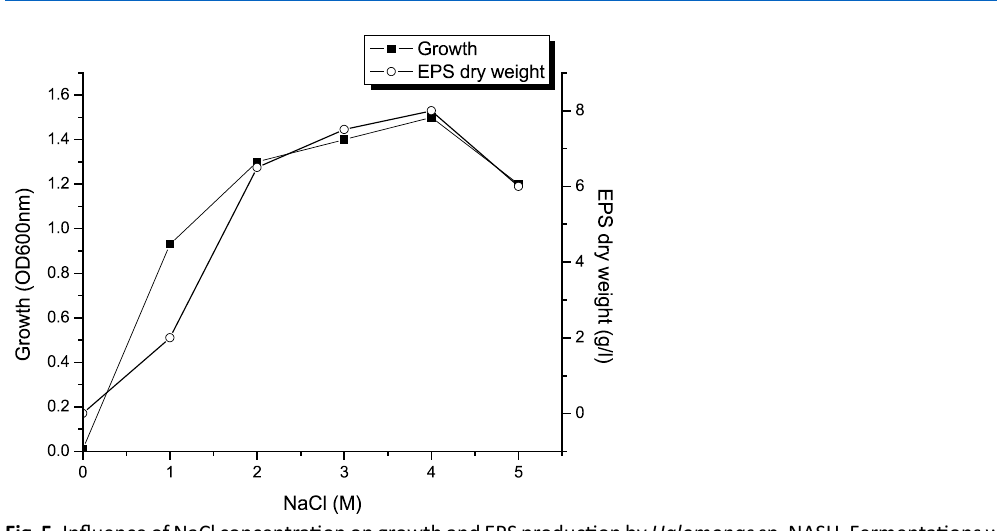
Fig. 5. Influence of NaCl concentration on growth and EPS production by Halomonas sp. NASH. Fermentations were carried out in IRAM medium under continuous shaking (200 rpm) at NaCl concentrations ranging from 0–5M, pH and temperature of 9 and 37°C with 1% (v/v) initial